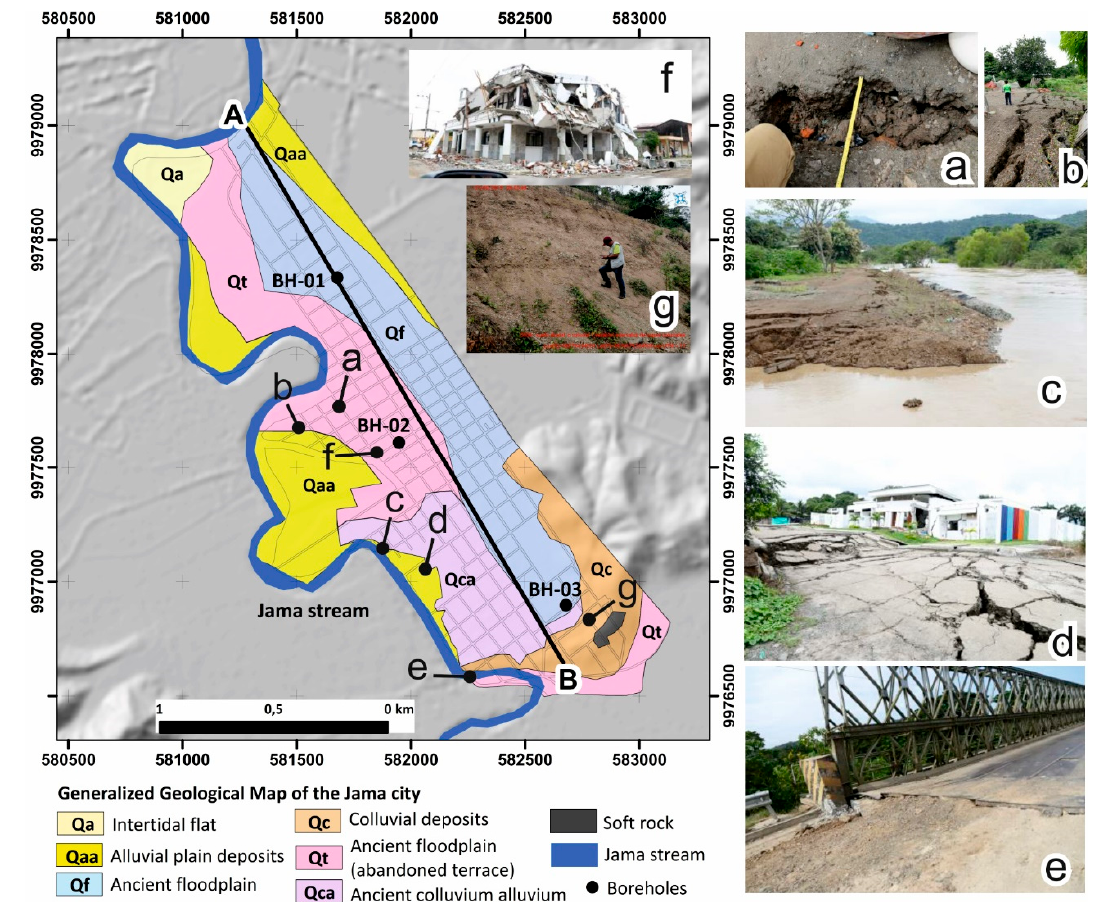
Figure 3. Geological map of the urban area of Jama city and earthquake environmental effects documented few days after the M7.8 2016 earthquake. ( a ) soil cracks on soil 120 m long and 38 cm wide, VIII ESI-07 intensity; ( b ) lateral spreading on filled sector on river side, VIII ESI-07 intensity; ( c ) lateral spreading in river bank, soil cracks in natural soil 20 to 25 cm wide, VII ESI-07 intensity; ( d ) ground deformation and subsidence, severe damage to the structure Sol de Oro (Economical and Social Inclusion Ministery), assigned IX ESI-07 intensity; ( e ) Ground subsidence above bridge anchorage, vertical uplift of 10 cm, VIII ESI-07 intensity; ( f ) building damage due liquefaction, flaws in the structural design of the building and the poor quality of the construction, VIII ESI-07 intensity; and ( g ) debris and rocks falls, VII ESI-07 intensity.